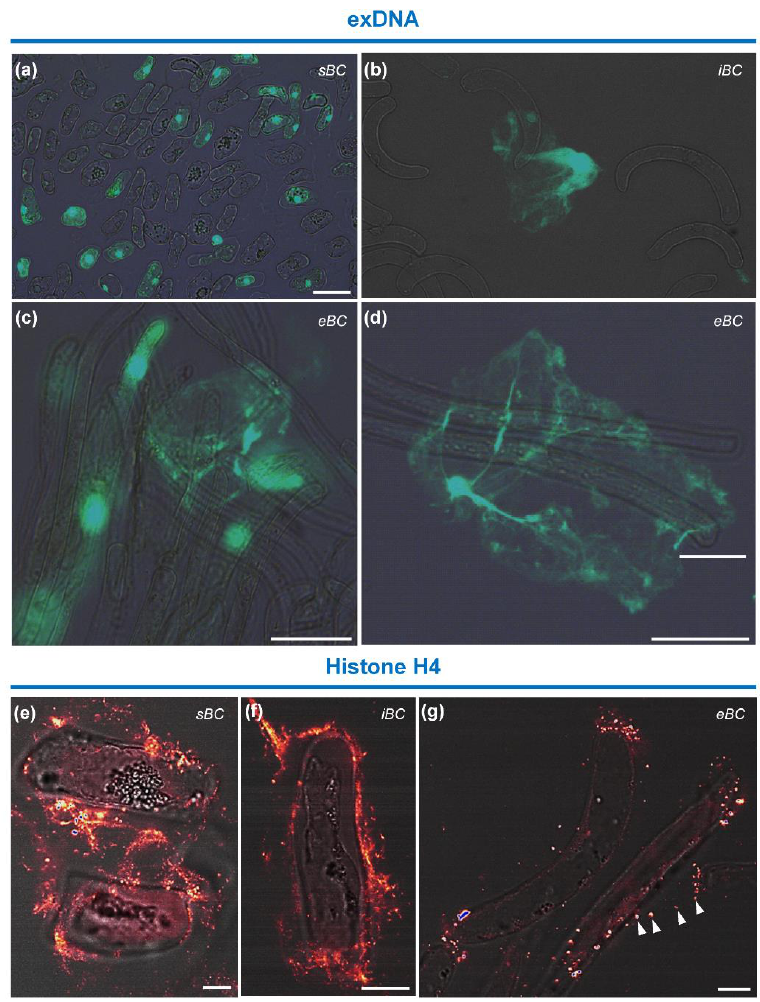
Figure 9. Staining of extracellular DNA and immunolabeling of histone H4 protein. ( a – d ) Images showing fluorescent staining of exDNA with the probe Sytox green. A fluorescence signal is observed in the extracellular matrix surrounding ( b ) iBC and ( c , d ) eBC. ( a ) No staining inside sBC. ( a , c ) Dead sBC or eBC are also stained. ( e – g ) Images showing labeling of the extracellular material surrounding the cells with anti-histone H4 antibody. Fluorescent spots can be seen along the filamentous material outside the cells (see arrowheads in ( g )). Scale bars: ( a – d ) 50 µm; and ( e , f ) 10 µm. Labeling of cells with the anti-histone H4 antibody showed a punctate signal in the extracellular area surrounding all three BC morphotypes (Figure 9e–g). The signal was sometimes visible along the filamentous structures between the cells (Figure 9e,f). In addition, in isolated eBC, fluorescence spots were observed to aggregate predominantly at the cell tips (Figure 9g). Therefore, histone 4